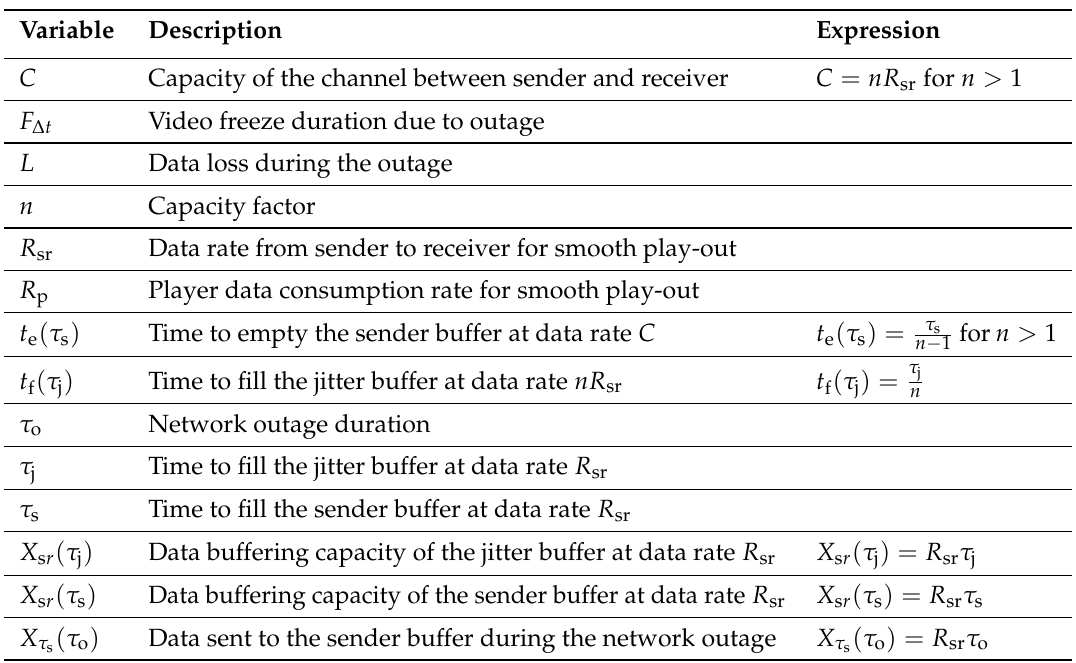
Table 1. Terminology used.